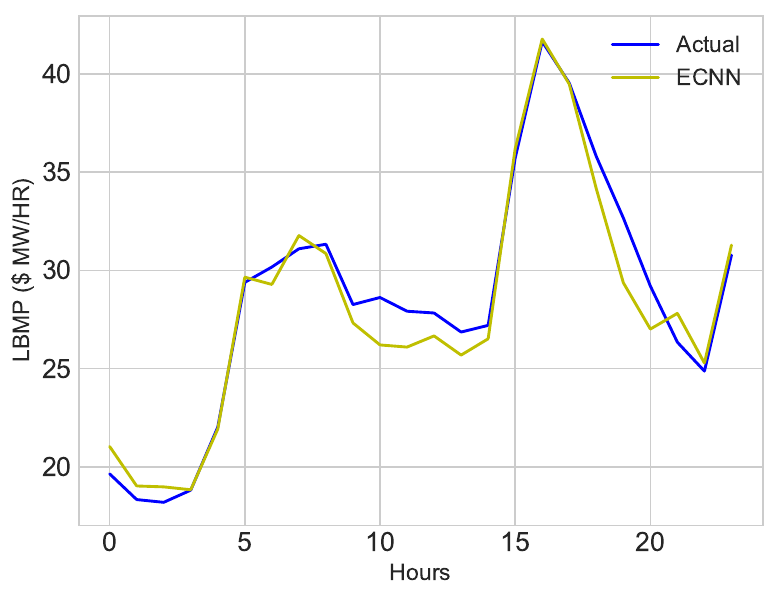
Figure 17. First Week of January, 2017.